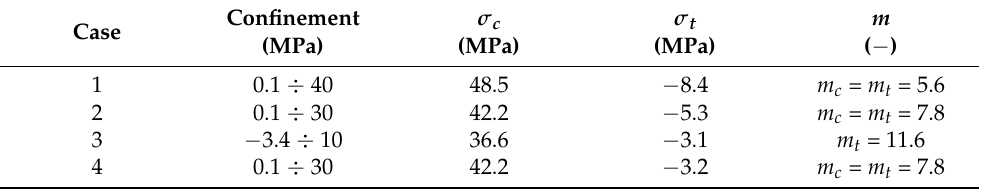
Table 1. Parameters obtained by data fitting of Vosges